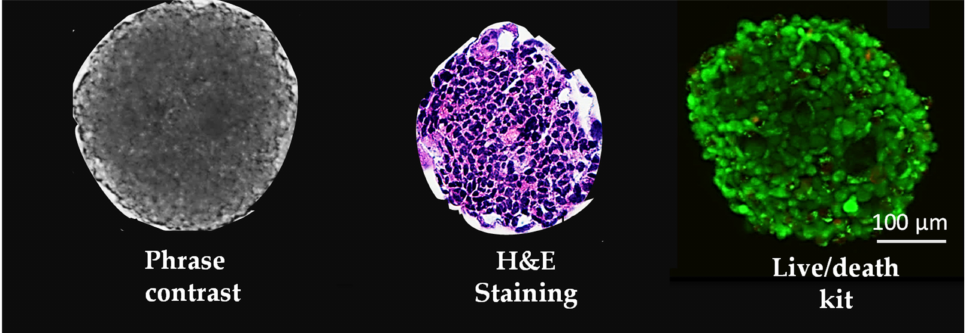
Figure 2. Three-dimensional (3D) renal organoids of human urine-derived stem cells (USC). Renal tubular organoids (4 × 10 3 cells, 338 ± 10 µ m at diameter) have been developed with human USC combined with the pig-derived kECM system to verify renal tubular-like structures located along with the outer surface of 3D spheroids one week after